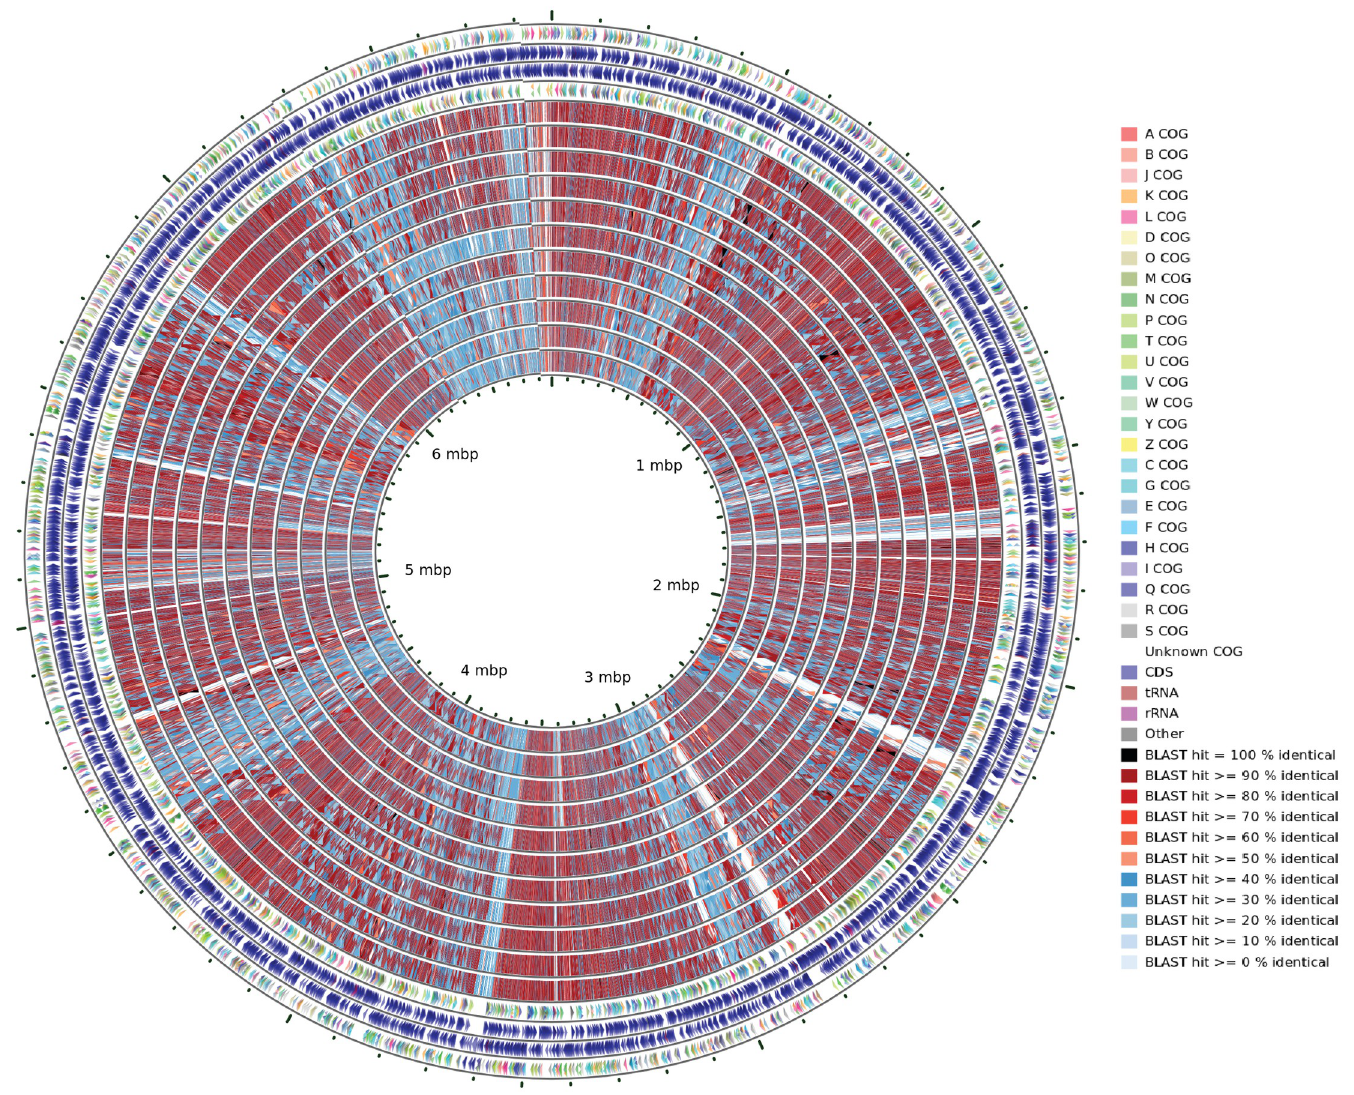
Fig 5. Whole-genome comparison between NMS14P and other 11 Methylobacterium strains. CGView Comparison Tools (CCT) program was implemented. The outermost track indicates the color-coded COG functional categories for reverse strand CDSs, the next two tracks represent reverse and forward strand sequence features, respectively, and the fourth track indicates color-coded COG functional categories for forward strand CDSs. The next 11 rings show the sequence similarity by BLAST comparisons between the reference genome ( Methylobacterium sp. NMS14P) and 11 Methylobacterium genomes, sequentially as follows: Methylobacterium radiotolerans ES_PA-B5, Methylobacterium radiotolerans JCM 2831, Methylobacterium organophilum DSM 760, Methylobacterium radiotolerans ME94, Methylobacterium radiotolerans NBRC 15690, Methylobacterium sp. C1, Methylobacterium radiotolerans RE1.2, Methylobacterium sp. XJLW, Methylobacterium oryzae CBMB20, Methylobacterium phyllosphaerae CBMB27, and Methylobacterium fujisawaense DSM 5686.